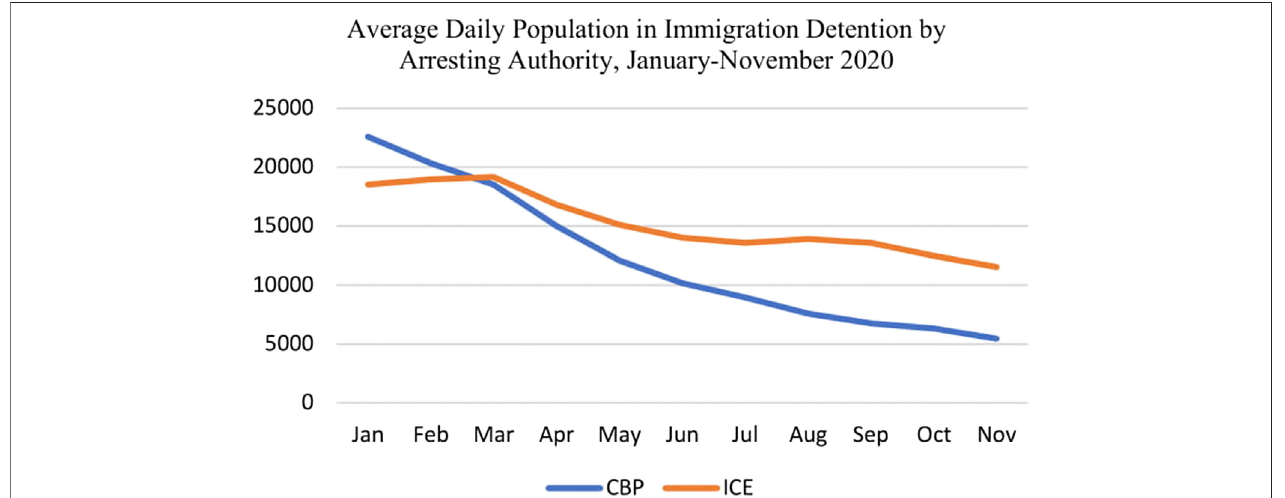
FIGURE2| Averagedailypopulationinimmigrationdetentionbyarrestingauthority,January-November2020.Source:Icedetentiondata,FY20YTD;icedetention data, FY 21 YTD.